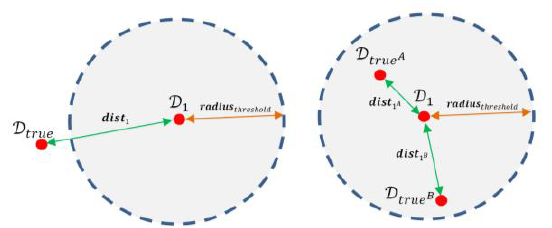
Figure 3. Concept of NNDR based